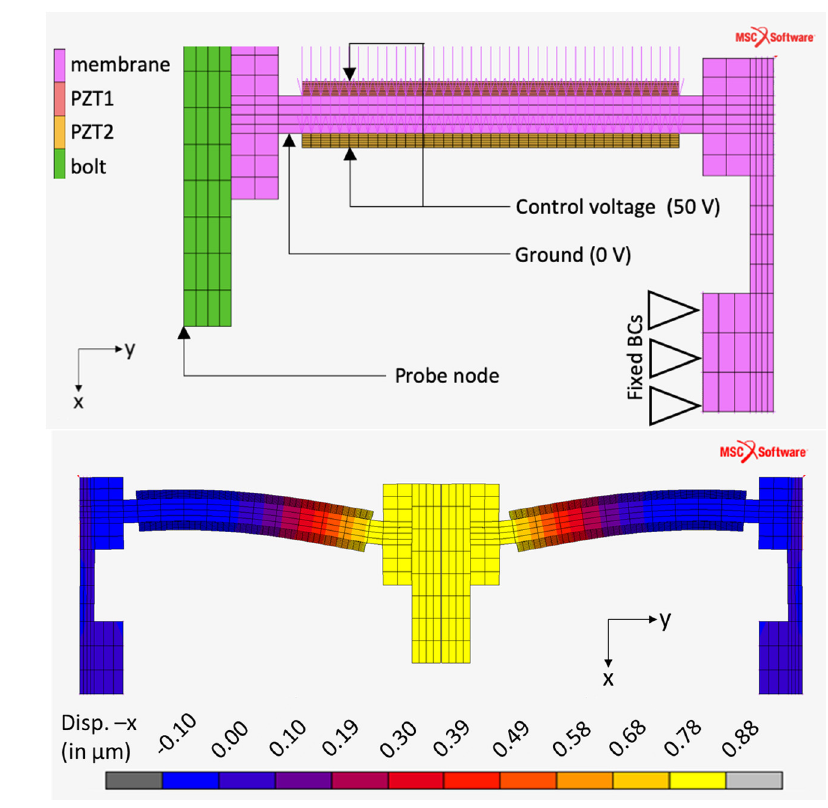
Figure 3. Finite element analysis of the piezo transducer. ( a ) Model definition and ( b ) vertical displacement results.